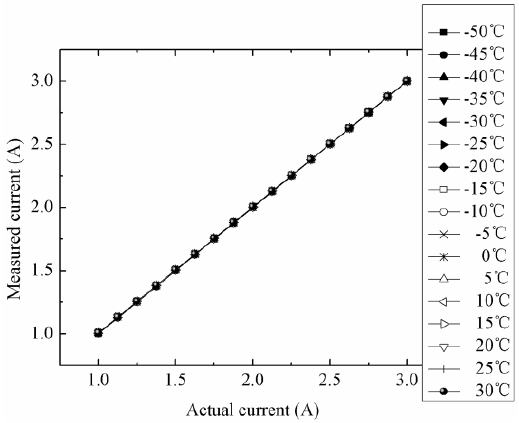
Figure 15. Temperature dependence of the current of the detection circuit.